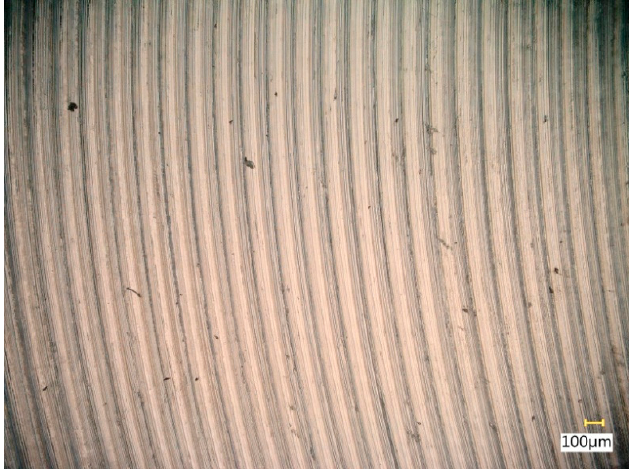
Figure 13. View of the surface after milling.